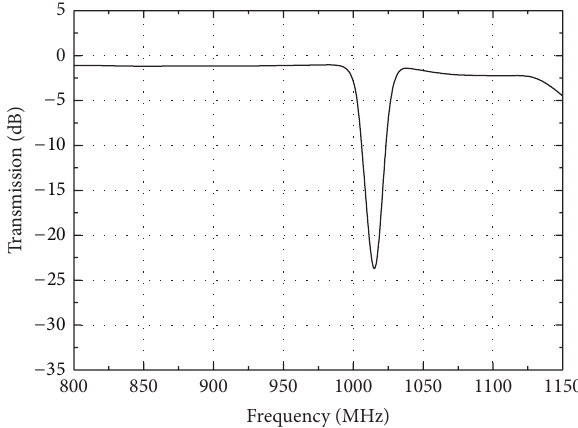
Figure2:Thetransmissioncoefficientofthecross-shapedstructure.